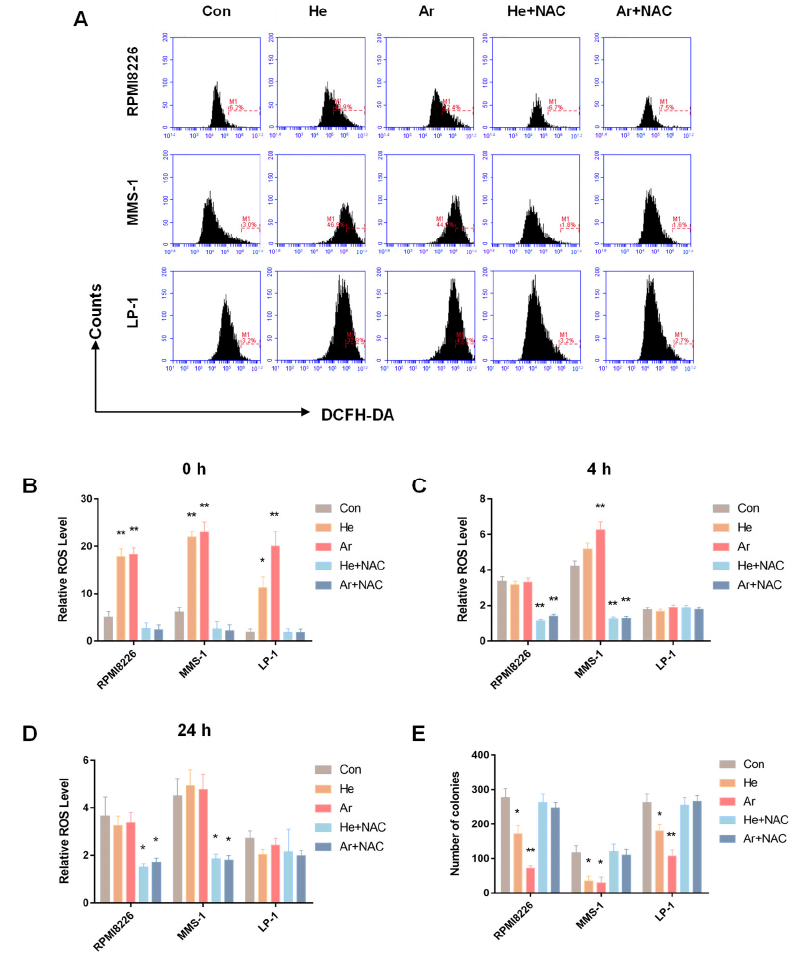
Figure 2. Plasma suppressed MM-cell-colony-formation abilities by increasing ROS. ( A ) RPMI8226, MMS-1, and LP-1 cells were pretreated with the ROS scavenger NAC (200 µ M), and then treated with He and Ar plasma for 20 s, followed by incubation with 10 µ M DCFH-DA for 20 min. DCF fluorescence was examined and quantified, ROS levels were measured at ( B ) 0 h, ( C ) 4 h, and ( D ) 24 h after plasma treatment. ( E ) Cells had been treated with NAC and plasma were then plated in CFC assays to assess clonogenic ability. Data represent the mean ± SD; * p < 0.05; ** p < 0.01 (Student’s t